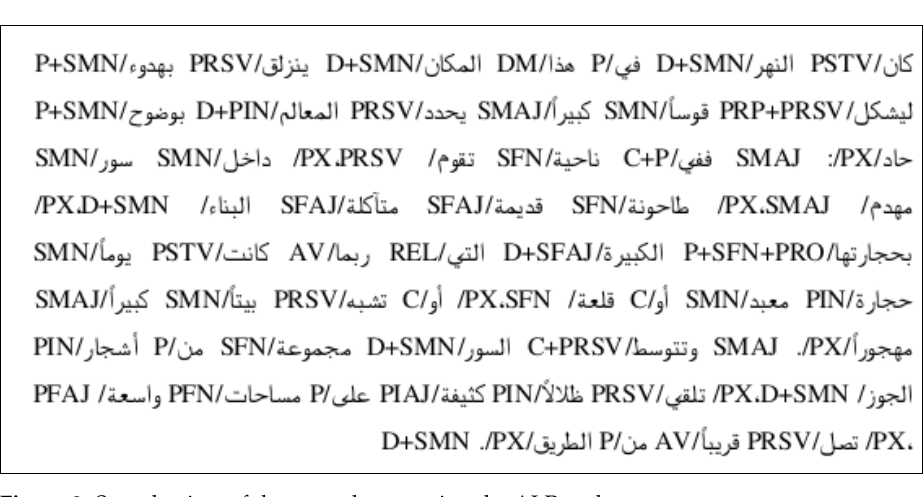
Figure 3. Sample view of the tagged texts using the ALP